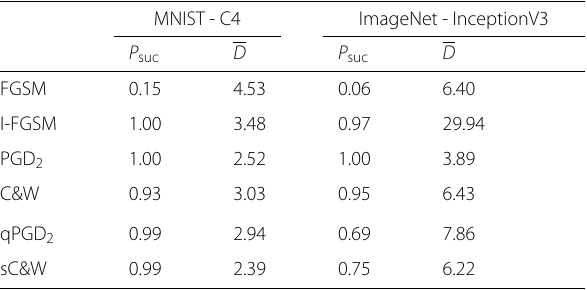
Table 2 Success probability and average L 2 distortion D when attacking networks adversarially trained against FGSM MNIST - C4 ImageNet - InceptionV3